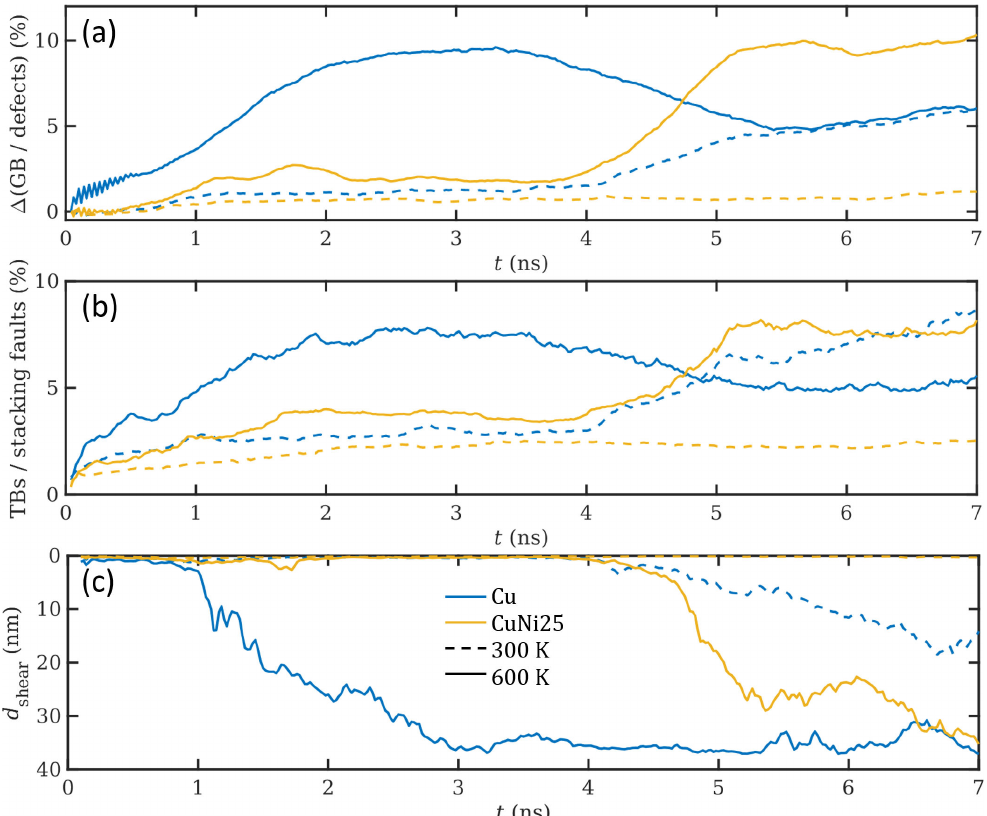
Figure 3. Time development of the excess grain boundary (GB) and defect fraction ( a ), the twin boundary (TB) and stacking fault fraction ( b ), and the shear layer thickness ( c ) of Cu and CuNi25 at 0.4